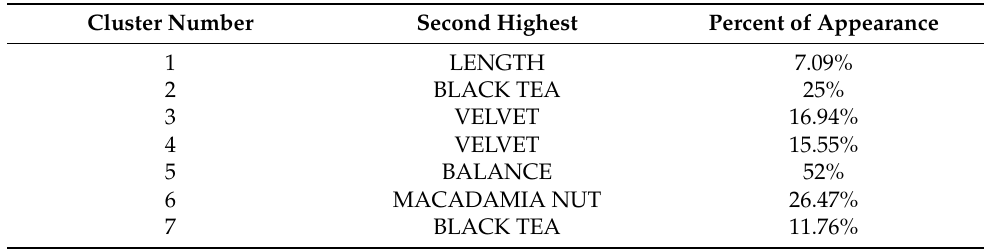
Table 5. Second highest common attributes. The lower percentage values are likely the result of utilizing a smaller, more specific dataset.